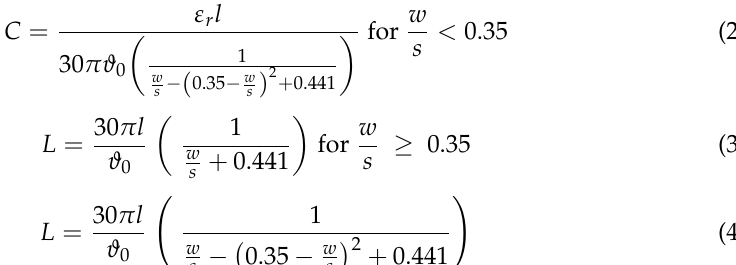
Figure 3. Vector s urface current at a resonant frequency. ( a ) Absolute amplitude values (top view).